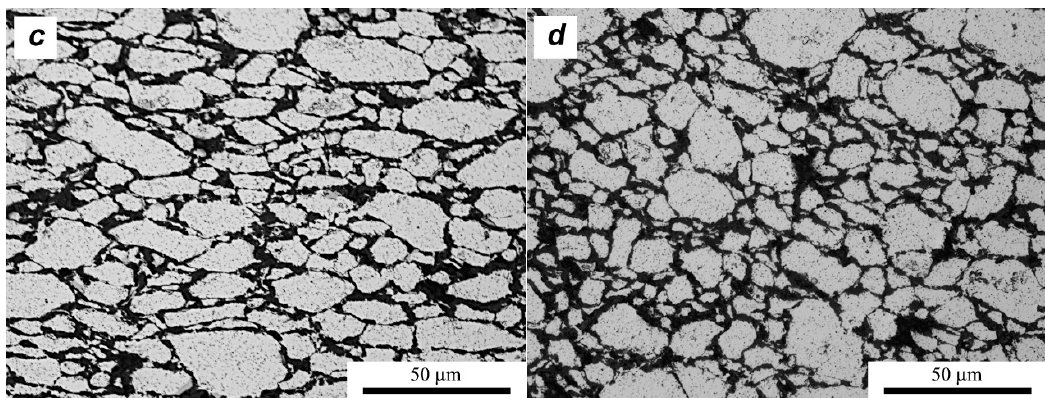
Figure 16. Microstructure of SPT samples AA6061/MoS 2 10 vol %: ( a ) center area λ = 1.5; ( b ) edge area λ = 1.5; ( c ) center area λ = 2; ( d ) edge area λ = 2.